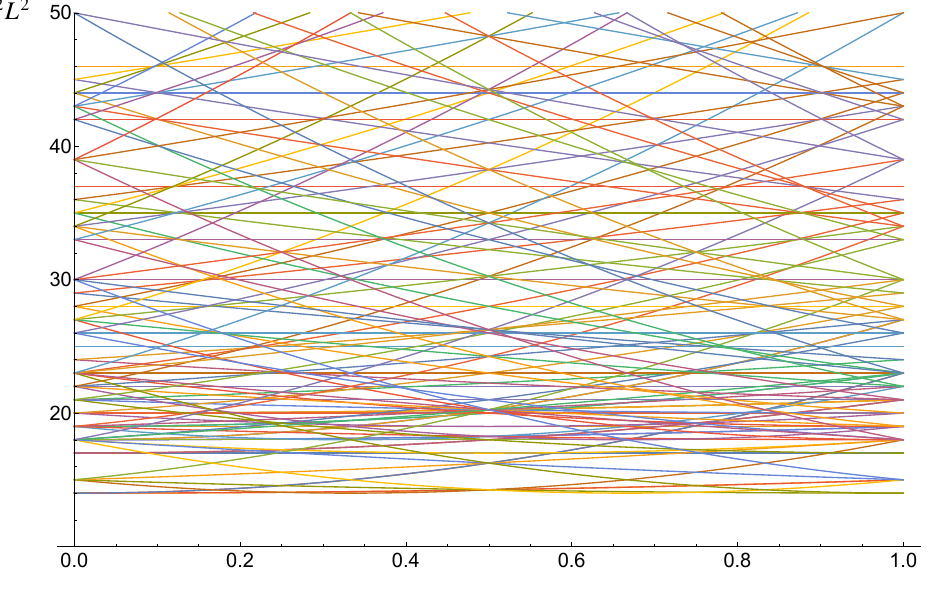
Figure 1 . Spin-2 masses at level ‘ = 3 , as a function of χ . L denotes the AdS 4 radius. from multiplet shortening of the second multiplet in (4.25) at level n = 2 . This is an